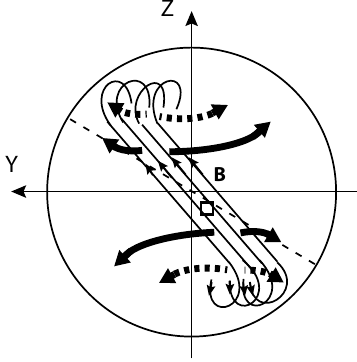
Figure 1. Schematic illustration of the untwisting of tail field lines under a positive IMF B y exposure (positive twisting), when viewed from the tail towards the Earth. The thick solid and dashed arrows indicate the expected azimuthal convection directions in the mag- netotail and the conjugate convection flows in the ionosphere, re- spectively. The thin dashed line marks the tilted neutral sheet. The black square marks a satellite position at an azimuthal flow reversal within the Earthward transported untwisting field lines (see Fig. 2) (after Grocott et al.,